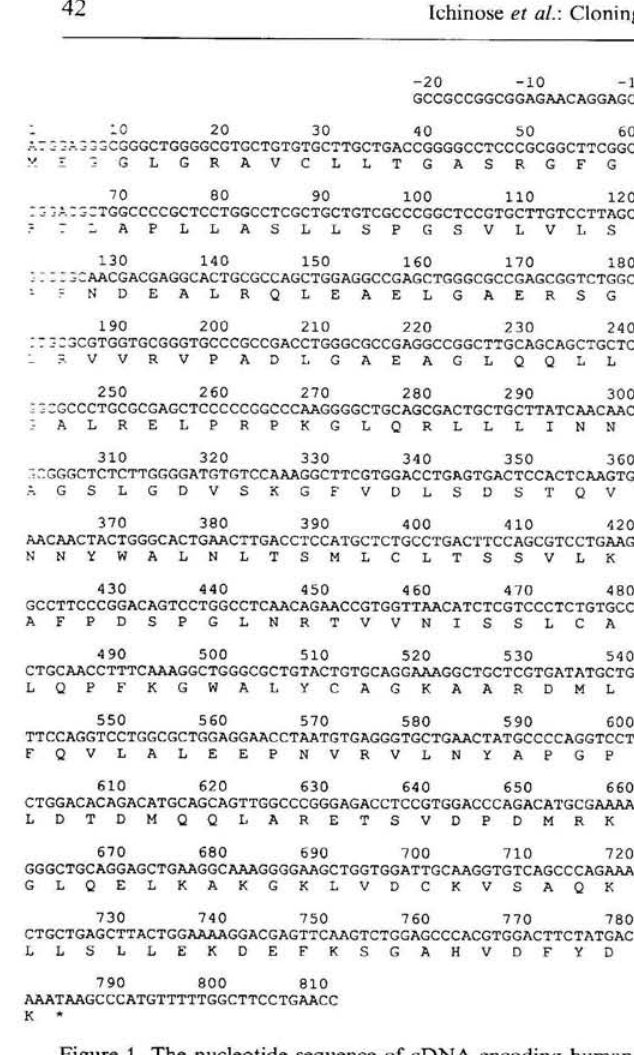
Figure 1. The nucleotide sequence of cDNA encoding human sepiapterin reductase and the deduced amino acid sequence. The predicted amino acid sequence is shown below the nucleo- tide sequence by one-letter